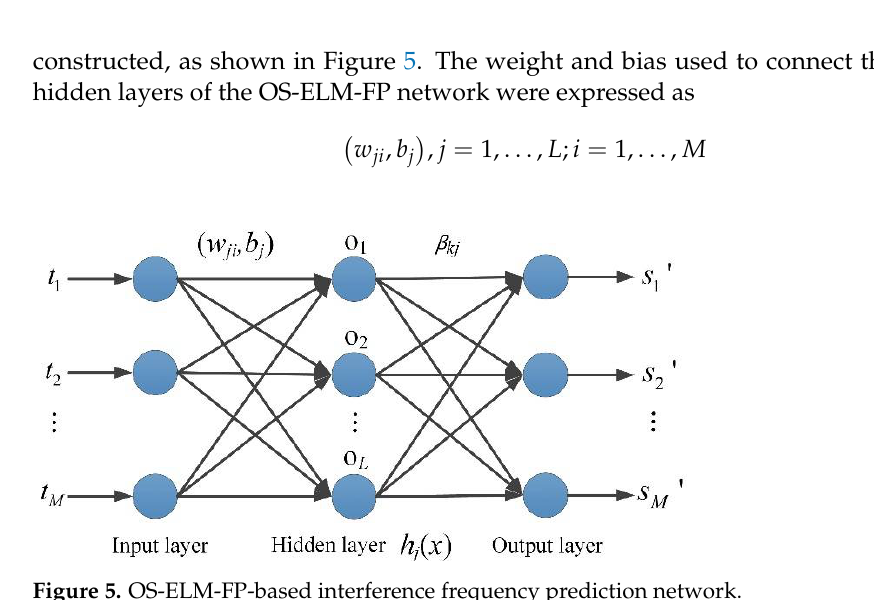
Figure 5. OS-ELM-FP-based interference frequency prediction network.